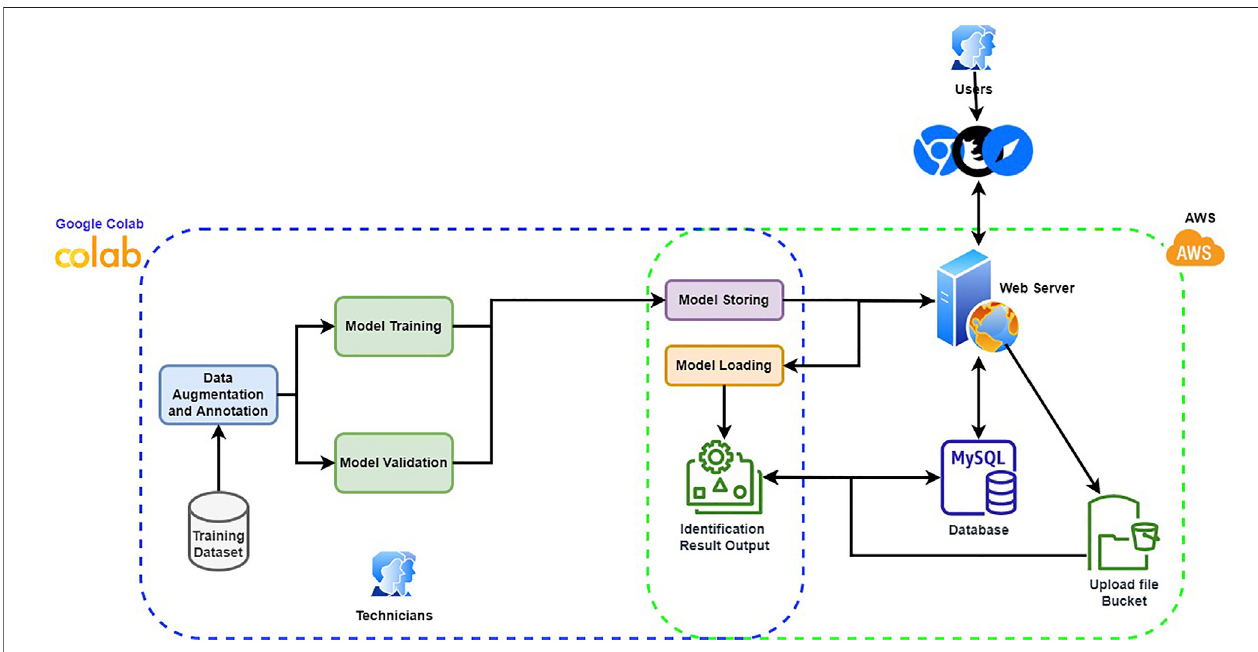
FIGURE 1 | Proposed supporting system diagram.